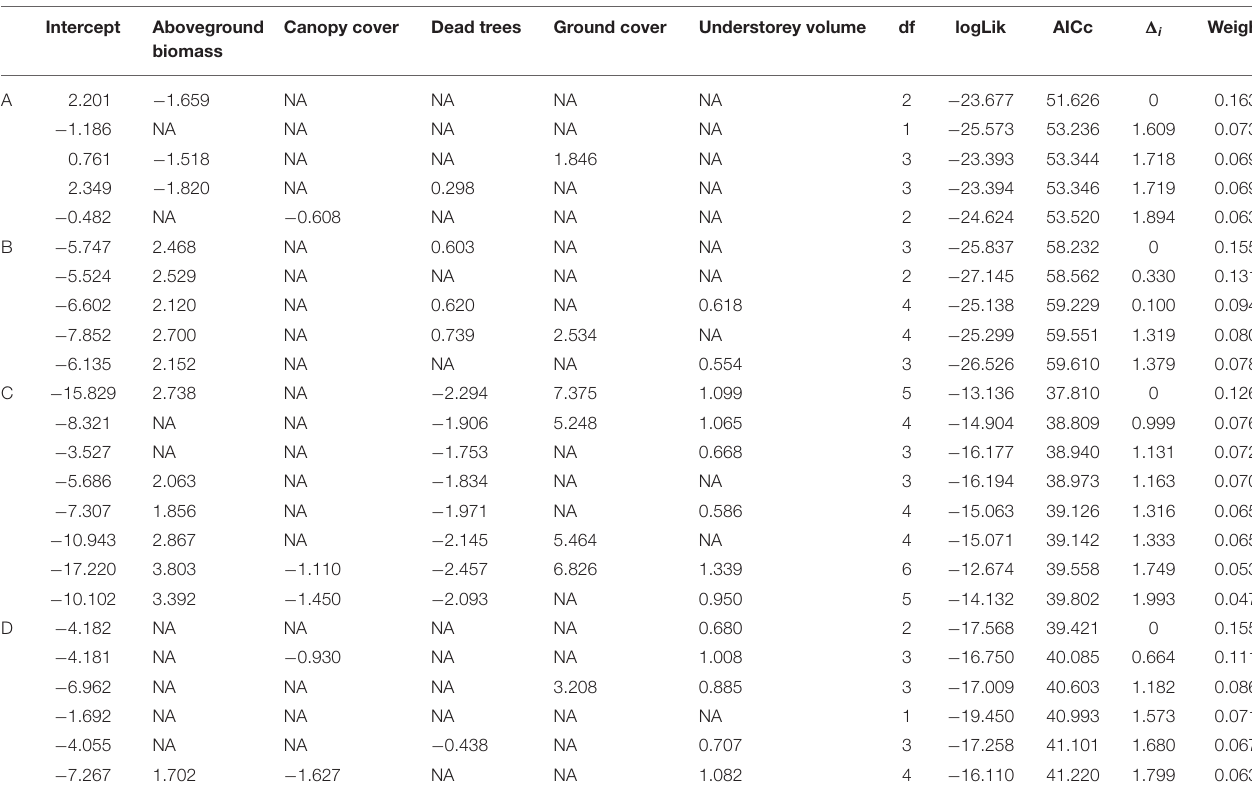
TABLE 3 | Standardized binary logistic regression coefficients and AICc values for top models with 1 i < 2.0 predicting predation events of (A) artificial nest; (B) artificial seed; (C) caterpillar model; and (D) frog model. Intercept Aboveground Canopy cover Dead trees Ground cover Understorey volume logLik biomass